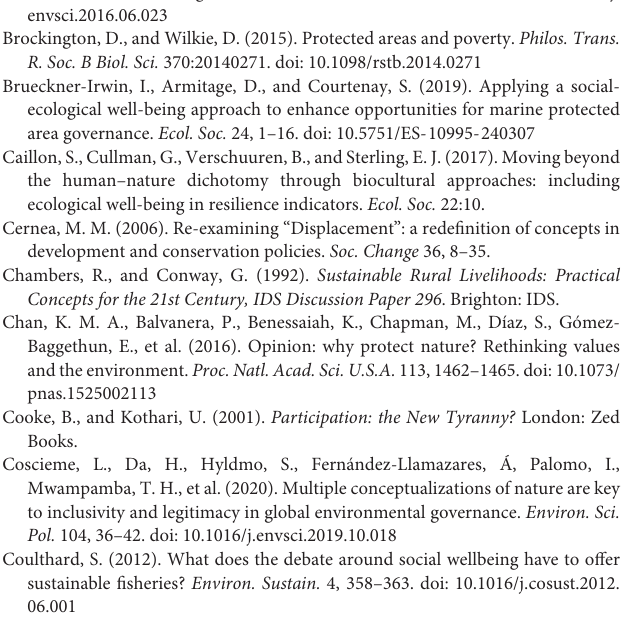
Figure 1 and Figure 2 are freely available for download